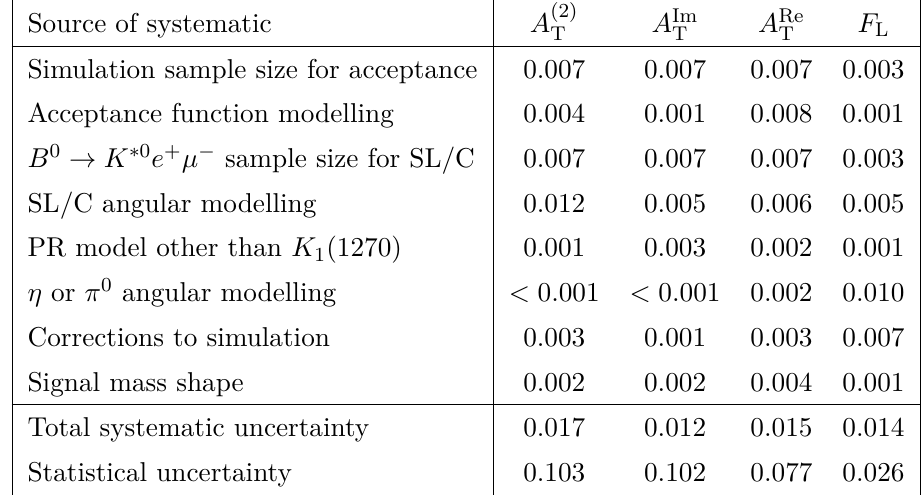
Table 1 . Summary of systematic uncertainties on the four angular observables, A (2) and F L . The total systematic uncertainty is the sum in quadrature of all the contributions. For comparison, the statistical uncertainties are shown in the last row of the table.